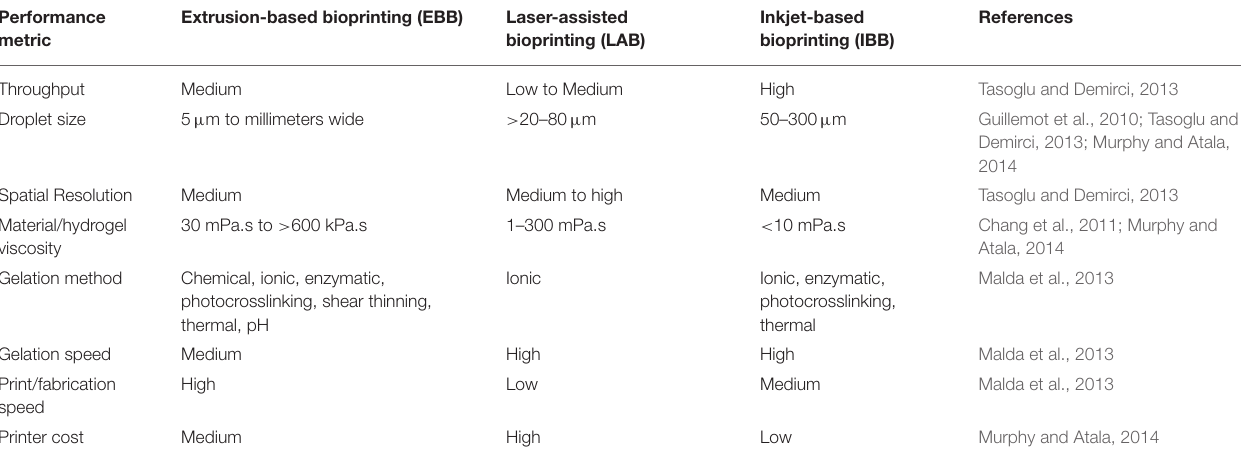
d Table adapted with permission from Knowlton et al.